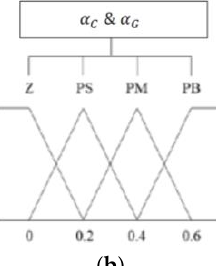
Figure 11. Membership functions of FLC-Output: ( a ) Language variable architecture of